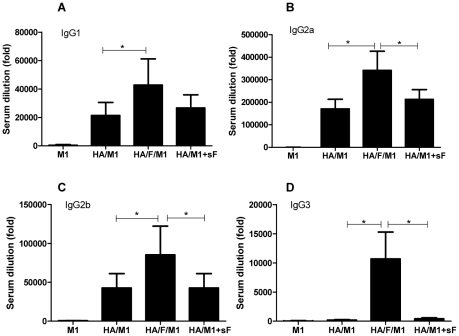
Endpoint titers of PR8-specific IgG subclasses.IgG subclass endpoint titers were determined as for serum IgG endpoint titer but using HRP-conjugated goat anti-mouse IgG1(A), IgG2a (B), IgG2b (C) or IgG3 (D) for detection.